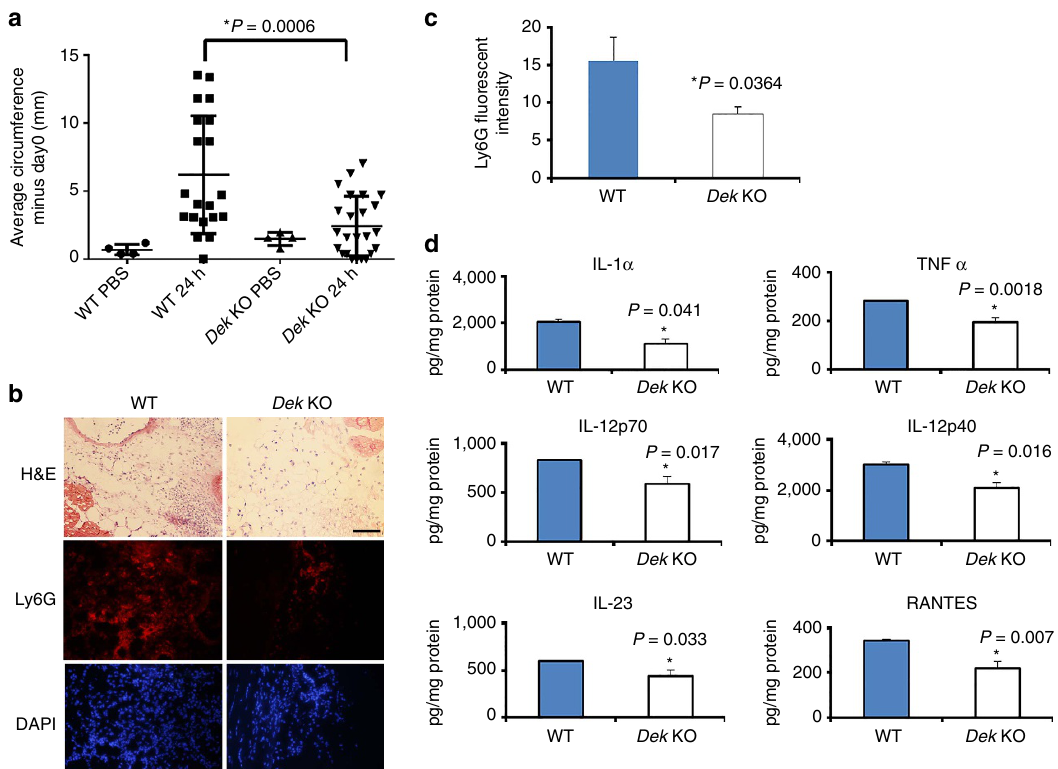
Figure 1 | Zymosan induction of joint inflammation is impaired in Dek -KO mice. ( a ) WTand Dek -KO mice were injected on day 0 with PBS or zymosan. Circumferences were measured at time of injection (day 0), as well as at 24h after injection. Mean values of the increase in knee circumference are shown at 24h after injection. The difference in the circumference at 24h between WTand Dek -KO mice was statistically significant (* P ¼ 0.0006), as determined by two-tailed, unpaired Student’s t -test (error bars, s.e.m.). Results shown are for individual mice and the average of four WT versus four Dek -KO for PBS control and 20 WTversus 23 Dek -KO mice for 24h after zymosan injection (results shown are from four independent experiments). ( b ) Representative hematoxylin and eosin staining of knee joint sections of three WTand three Dek -KO mice 24h after zymosan injection are shown in the top panel. In the middle panel, joint sections were analysed for neutrophils by immunohistochemistry using the murine neutrophil surface marker Ly6G (in red) 24h after intra-articular injection. Sections stained for cell nuclei with DAPI (blue) are shown in the lower panel. Magnification (cid:3) 40 (scale bar 100 m m). ( c ) Arbitrary fluorescent intensity of Ly6G staining was analysed for three different fields of each section of six WT and five Dek -KO zymosan-injected knees (* P ¼ 0.0364), as determined by two-tailed, unpaired Student’s t -test (error bars, s.e.m.). Mean fluorescent intensity of the whole section was determined by Image J. ( d ) Inflammatory cytokine profile of knee homogenates 24h after zymosan injection, as detected by ELISA. Cytokine levels were normalized by protein concentration and were significantly lower in Dek -KO versus WT knee homogenates (error bars, s.e.m.). Results shown are average cytokine levels from 7 WT and 11 Dek -KO